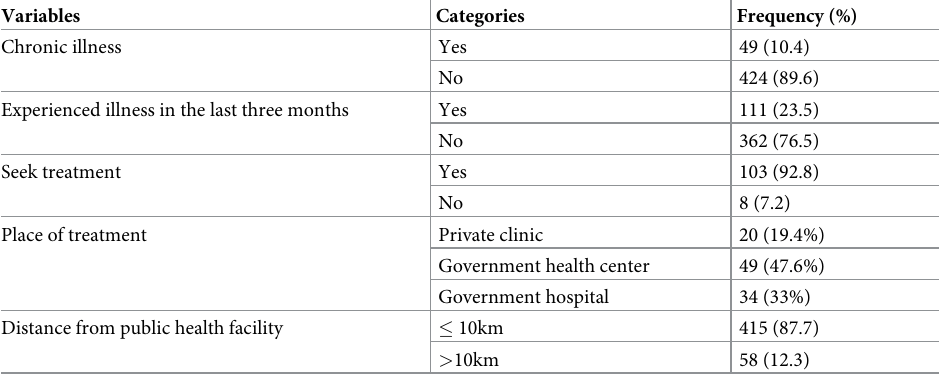
Table 2. Healthcare characteristics of respondents in Lemu and Bilbilo Woreda, 2021.